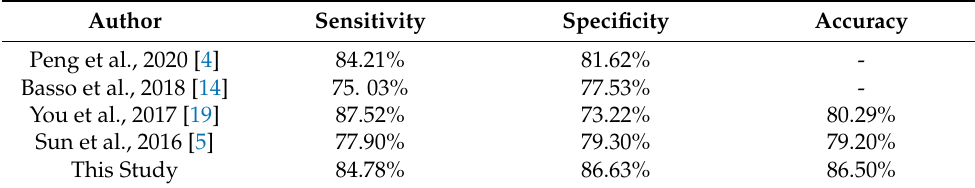
Table 5. Comparison of risk prediction effects in different studies.